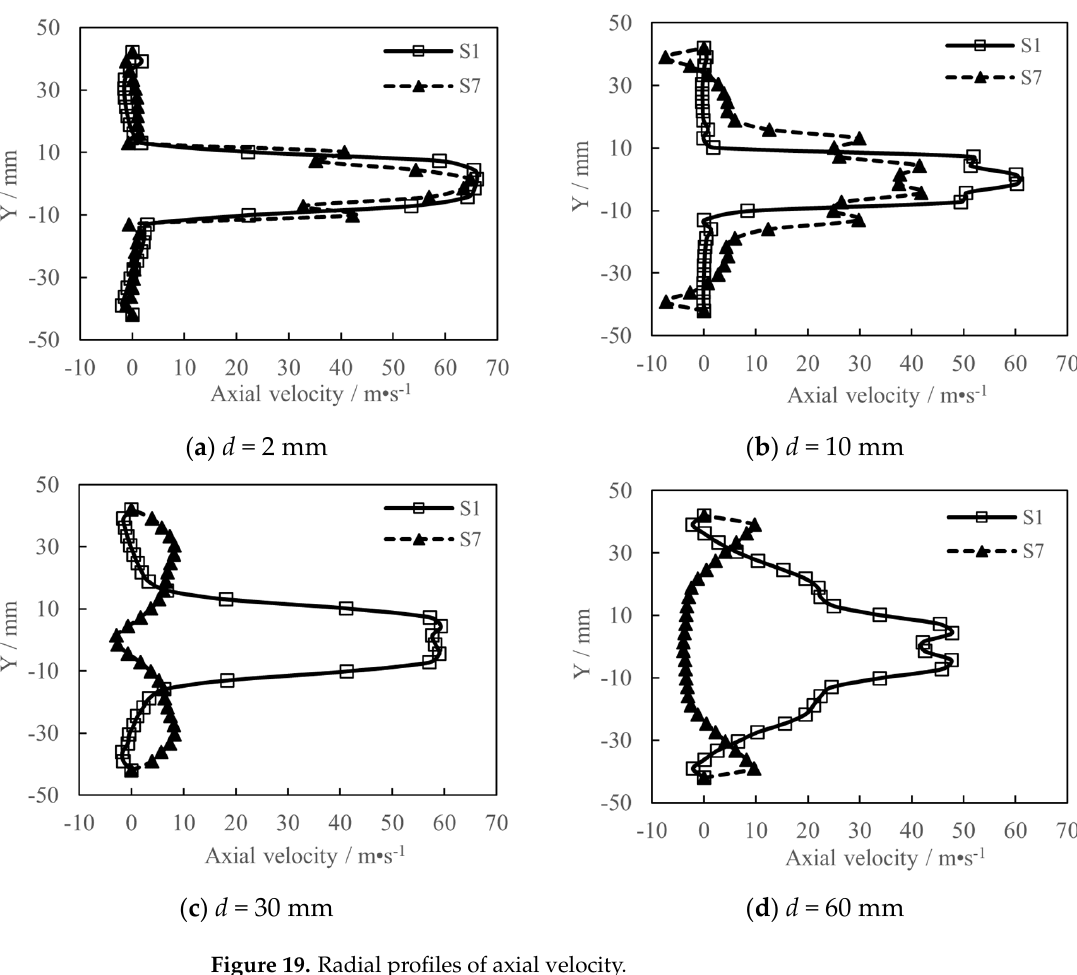
Figure 18. Tangential velocities contours under different sleeve angles.